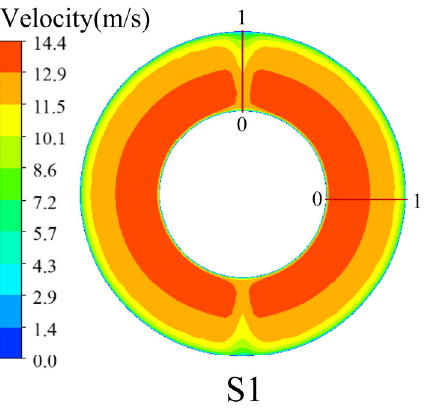
Figure 5. Schematic diagram of the relative positions of the cross-sections of the injector.